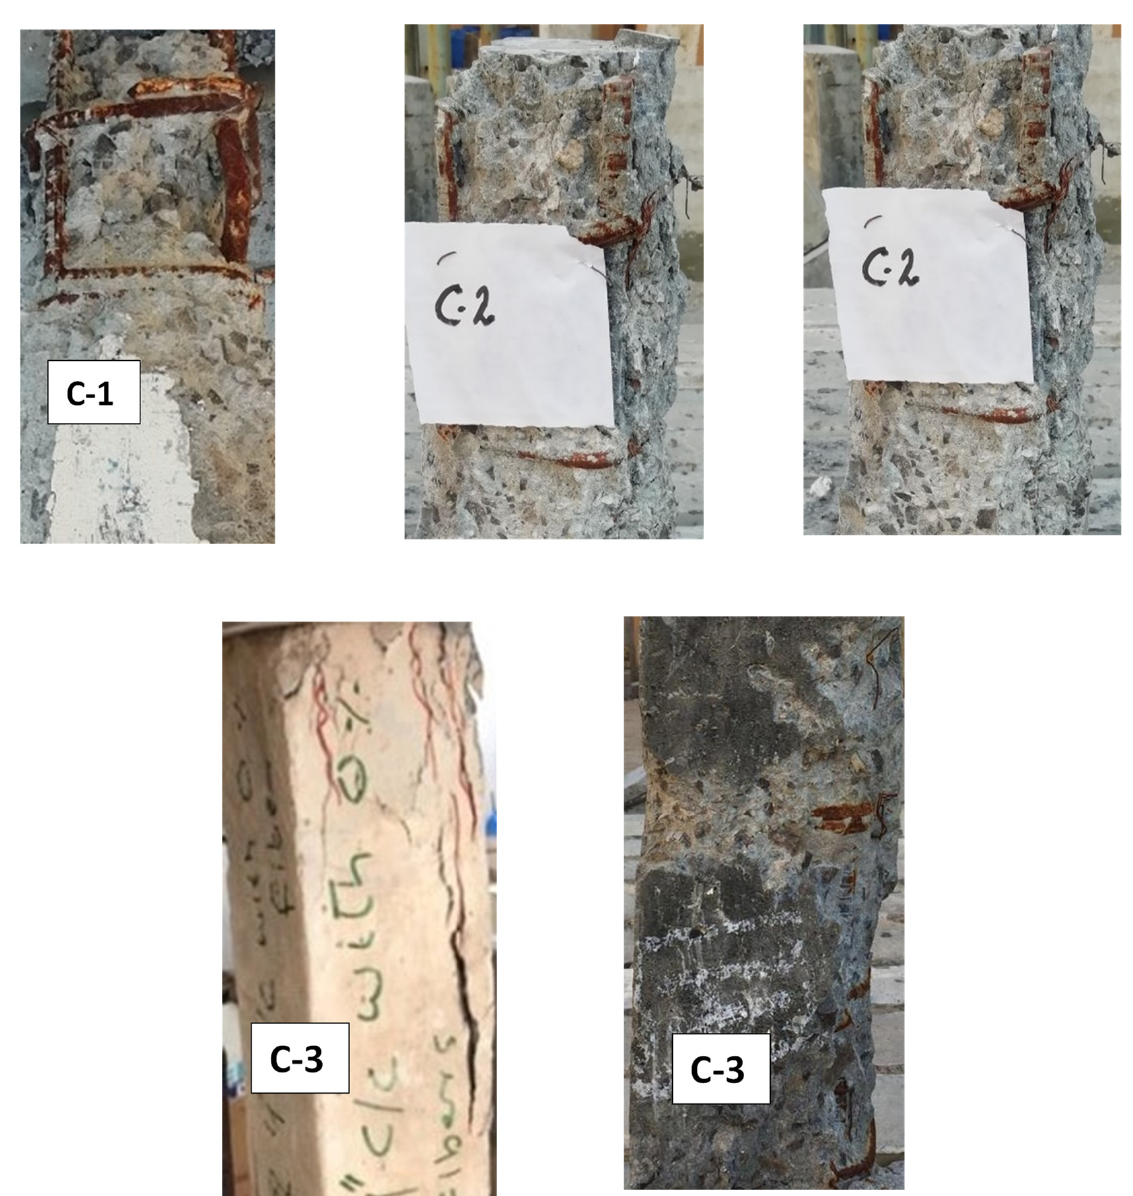
Figure 11. Failure modes of column specimens.